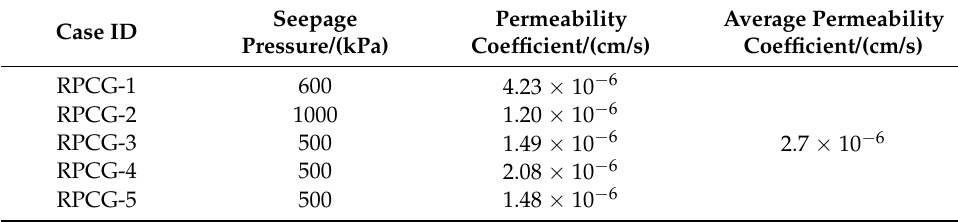
Table 7. Permeability coefficients of RPCG.